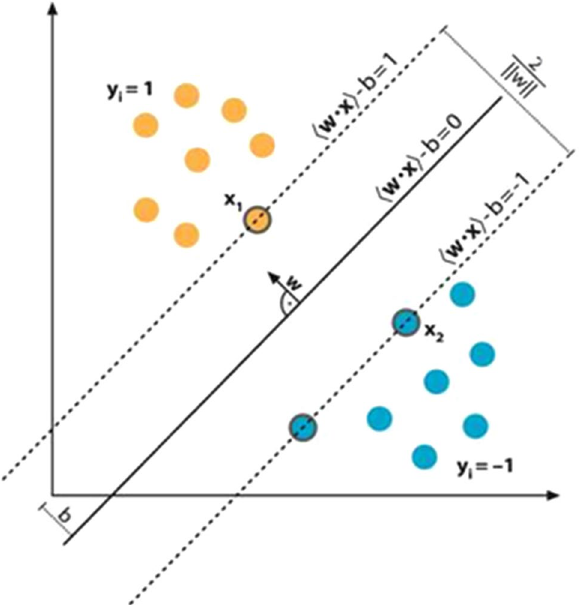
Fig. 15 The general configuration of an RBF